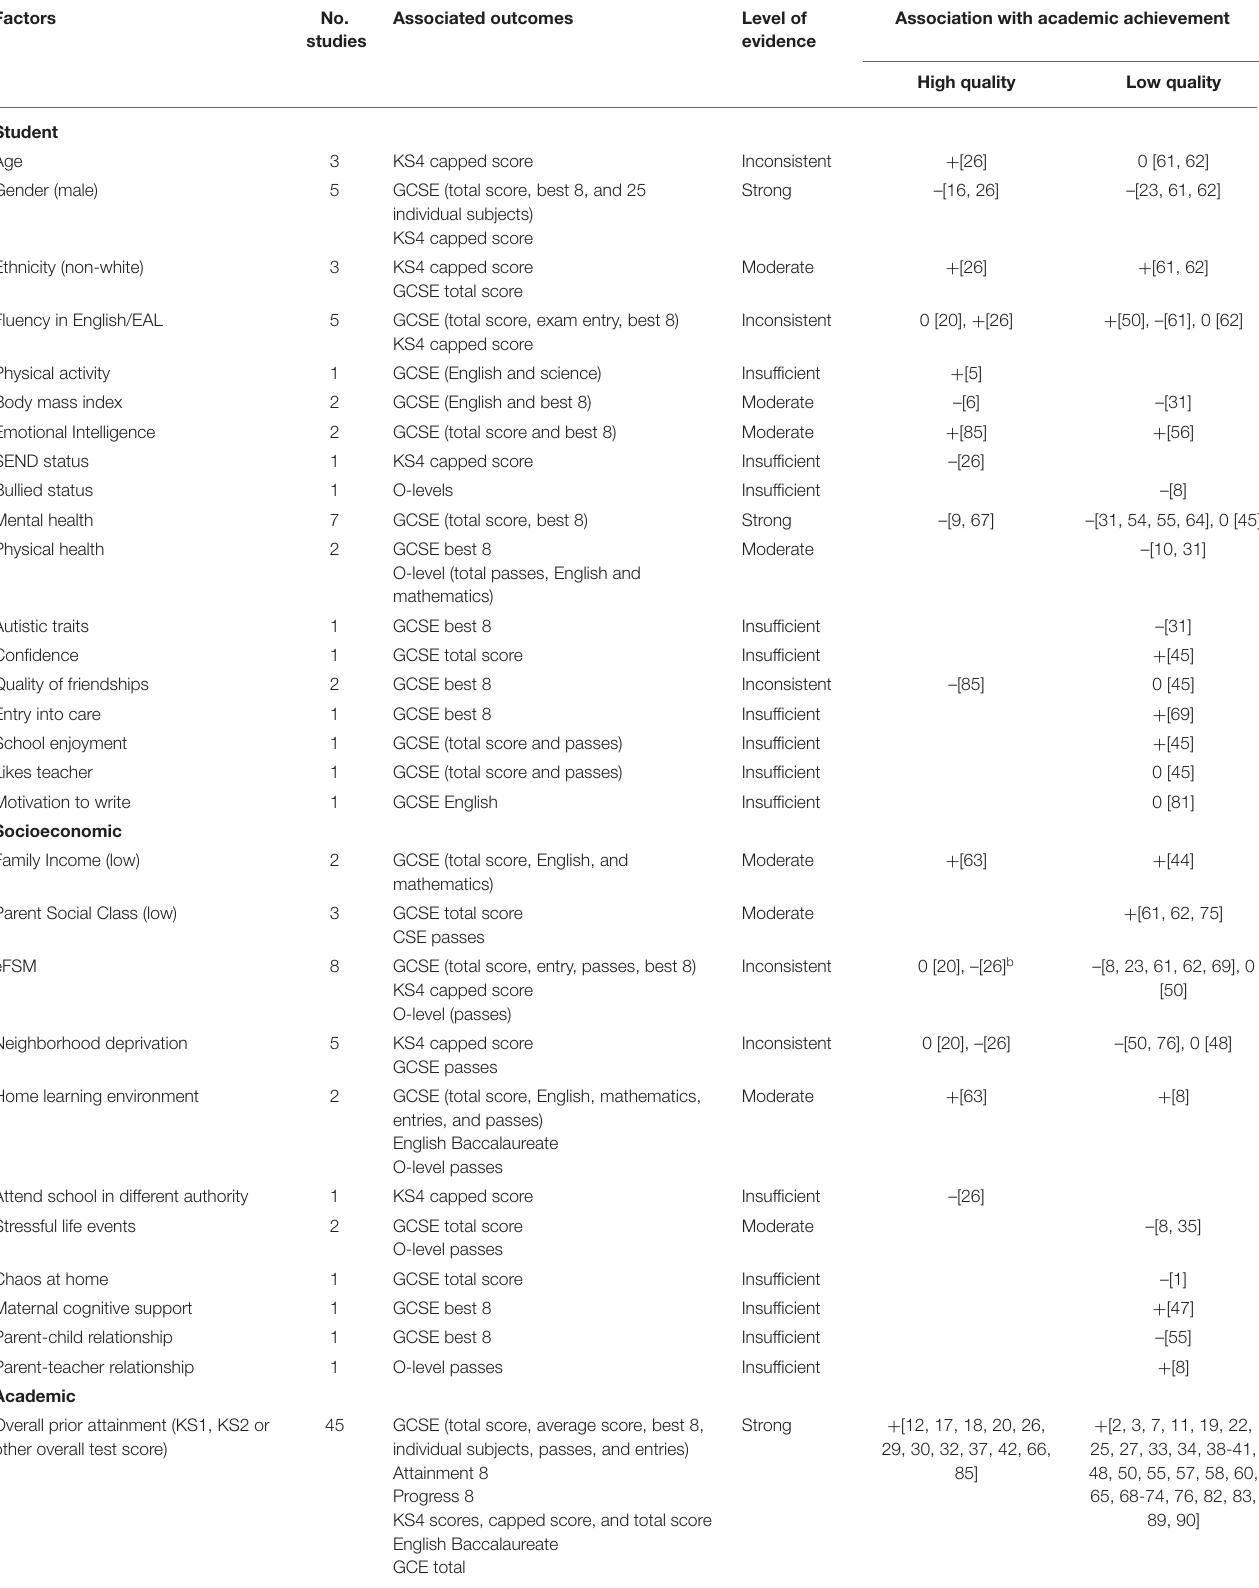
TABLE 2 | Study synthesis indicators.